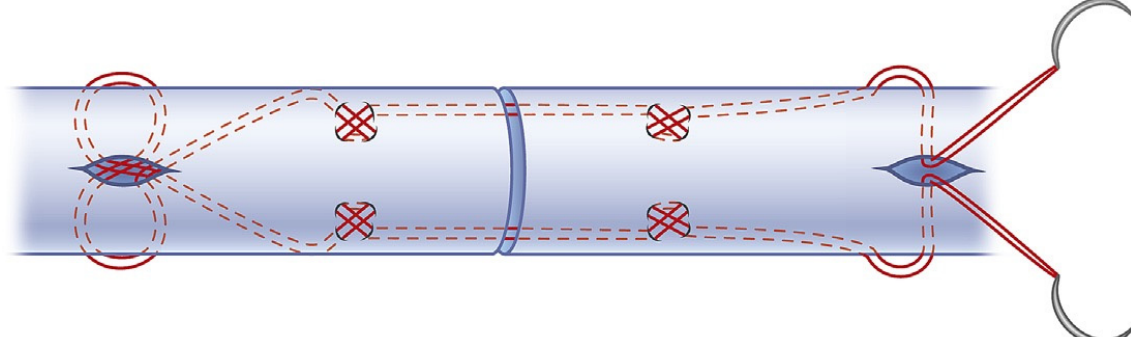
Figure 2. 4-strand modified suture technique by Tsuge [14].